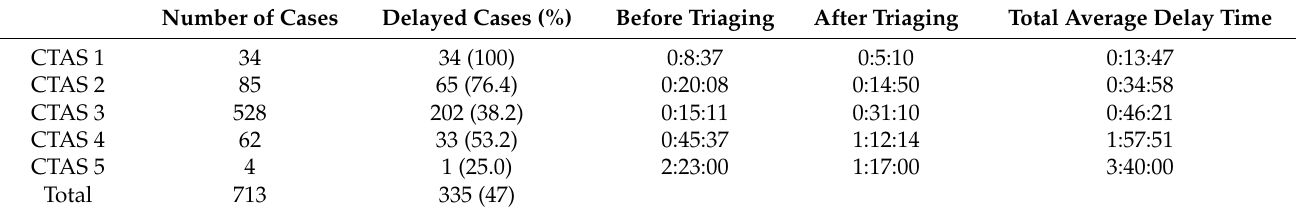
Table 3. Average delay time.